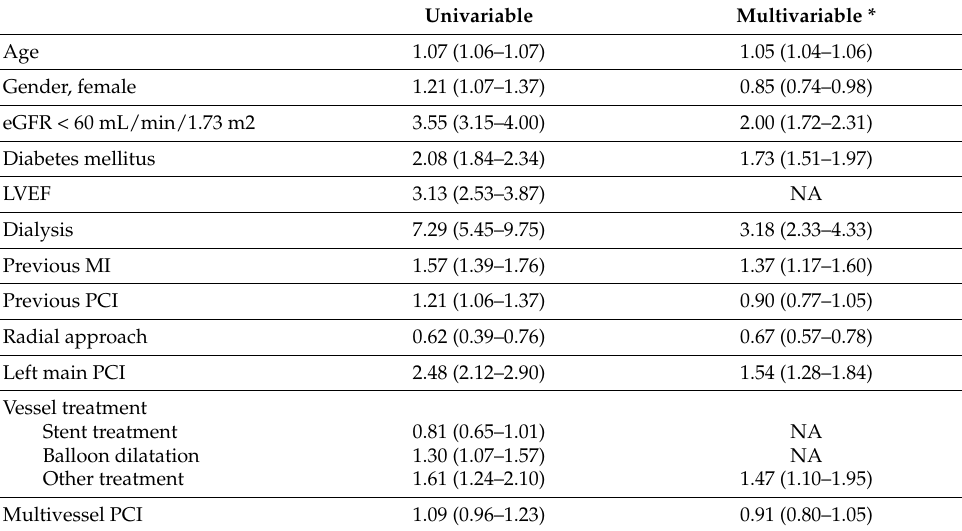
Figure 2. Kaplan–Meier curve showing the all-cause mortality and reinterventions at long-term follow-up in the overall cohort ( A , C ) and propensity score–matched cohort of multiple imputation dataset 1 ( B , D ). Abbreviations as in Figure 1. * Represents the pooled p -value for all five propensity score–matched cohorts. Table 3. Cox proportional model of multivariable analysis of predictors of all-cause mortality at long-term